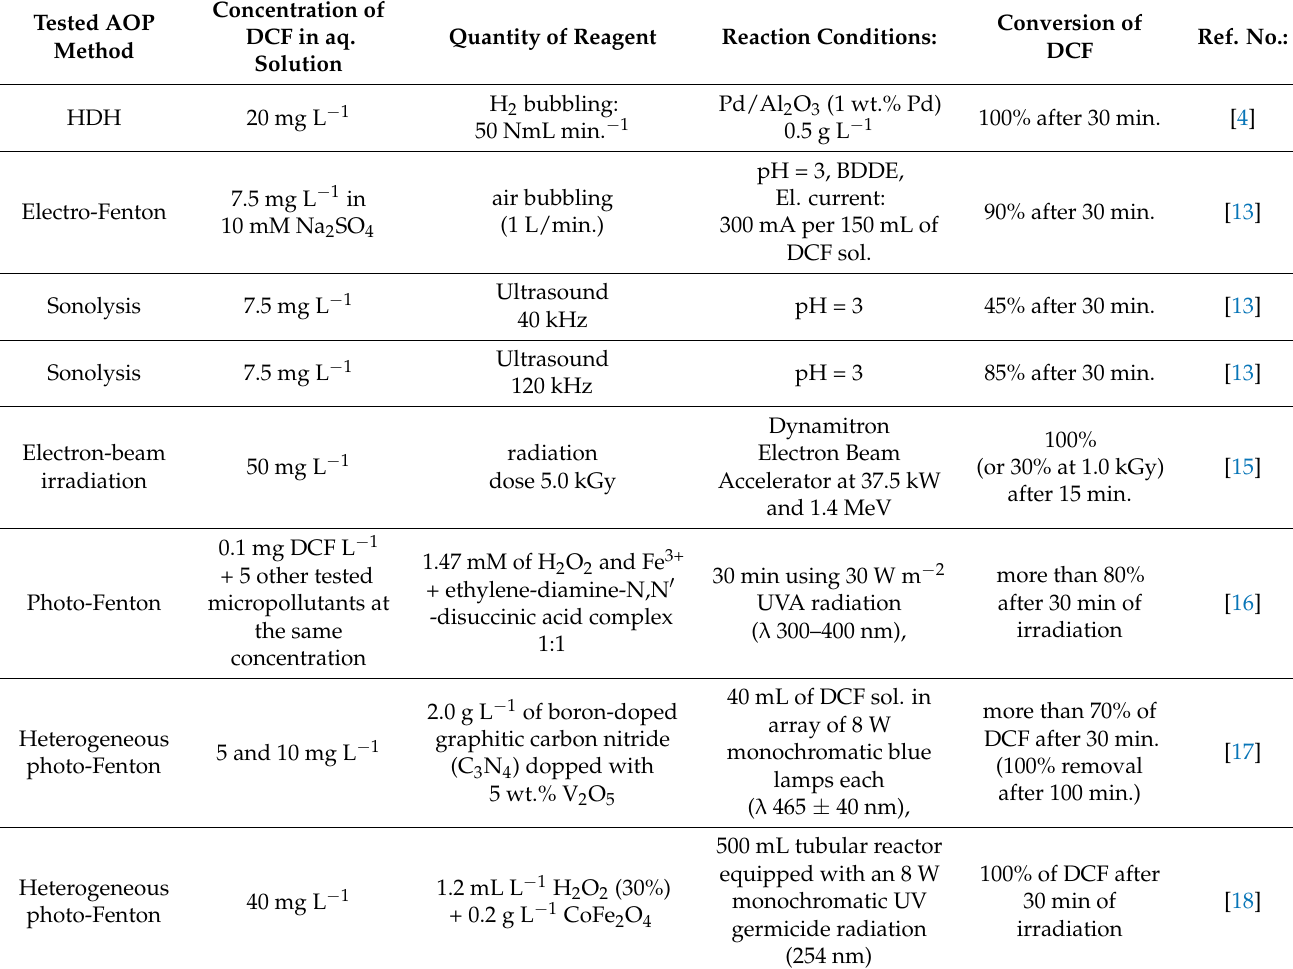
Table 1. The comparison of published methods tested for DCF destruction at 25 ◦